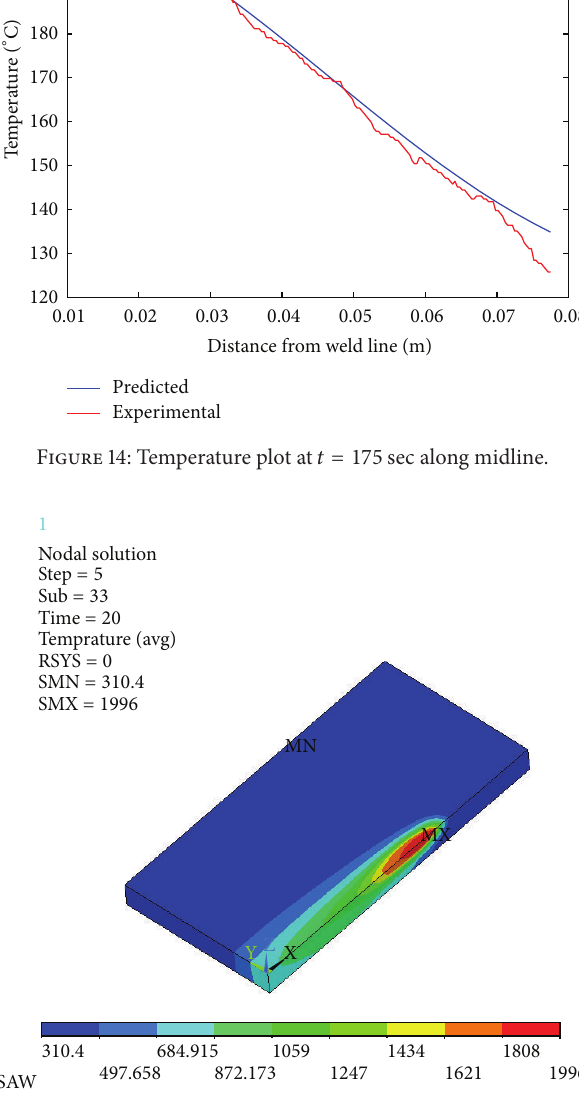
Figure 15: Temperature profile of the plate at 𝑡 = 20 sec after the start of welding (for heat input of 10200